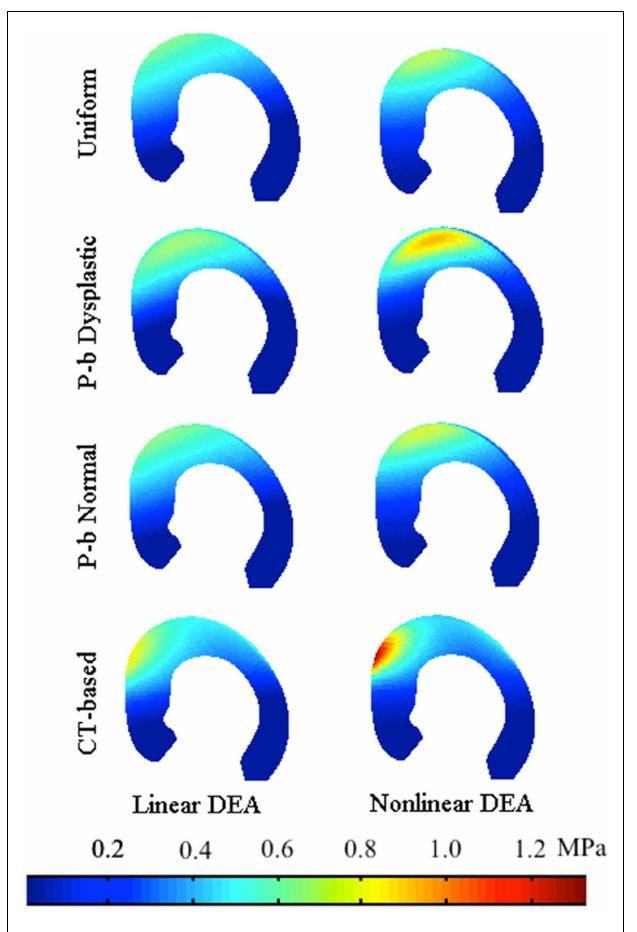
FIGURE 7 | Pressure profile of a sample acetabulum loaded by the standing force (medial view) . In this subject, the non-linear DEA-predicted higher stress levels over the acetabulum.